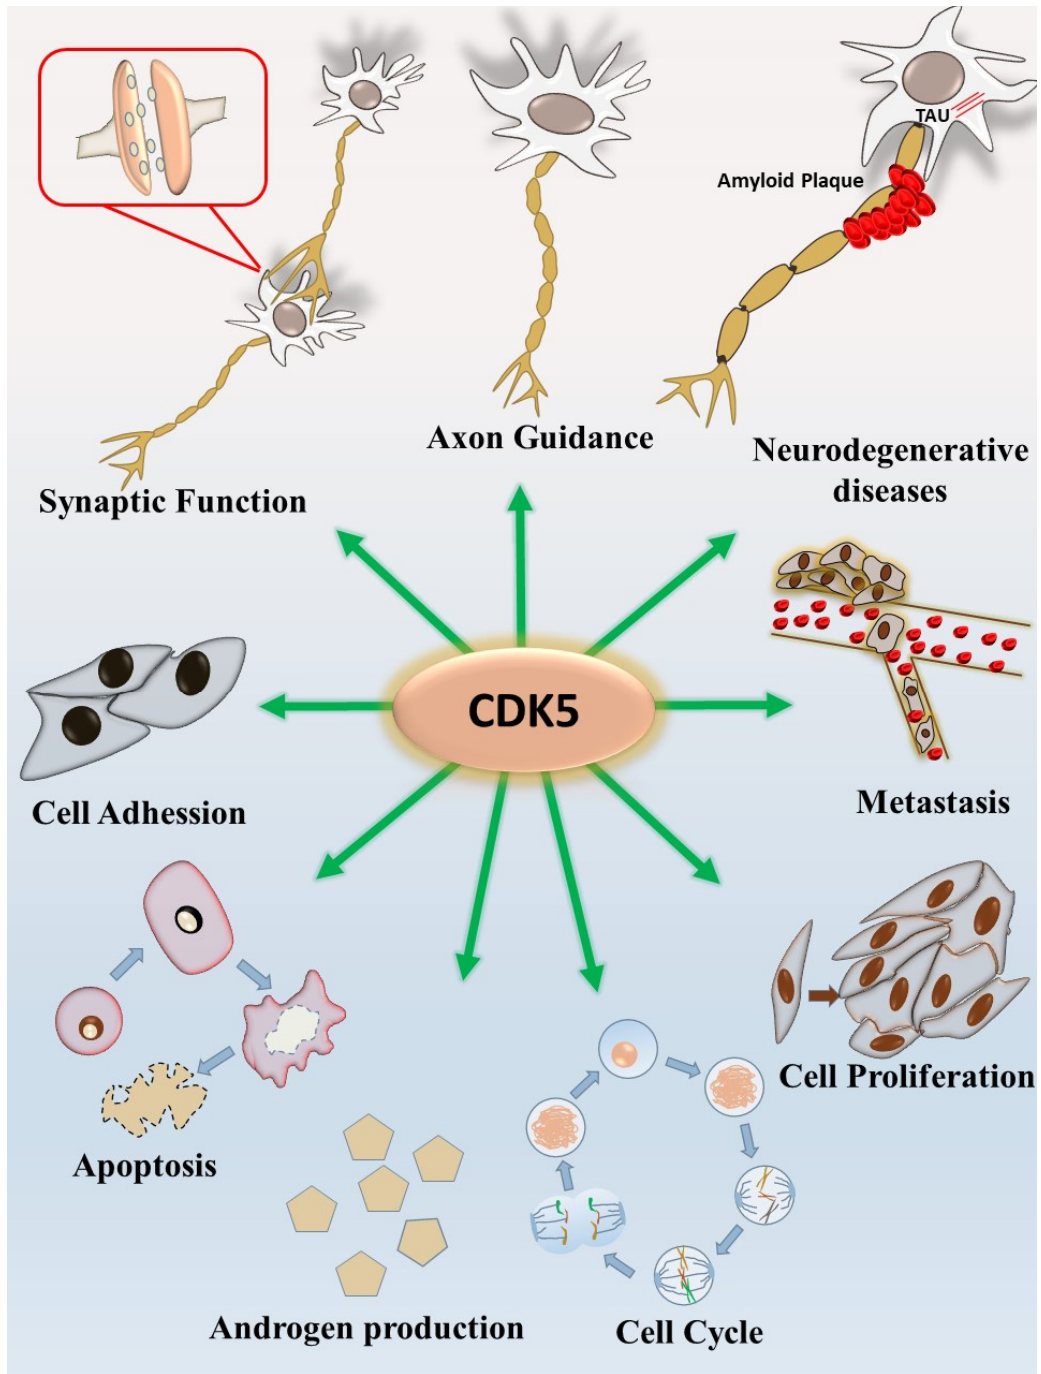
Figure 1. A summary of the various cyclin-dependent kinase 5 (CDK5)-mediated biological processes. CDK5 plays important roles not only in the central nervous system but also in different biological processes. Functions in the central nervous system include synaptic function, axon guidance, cell adhesion, and neurodegenerative diseases. Functions outside of the central nervous system include androgen production, cell cycle, cancer cell proliferation/apoptosis, and tumor metastasis.